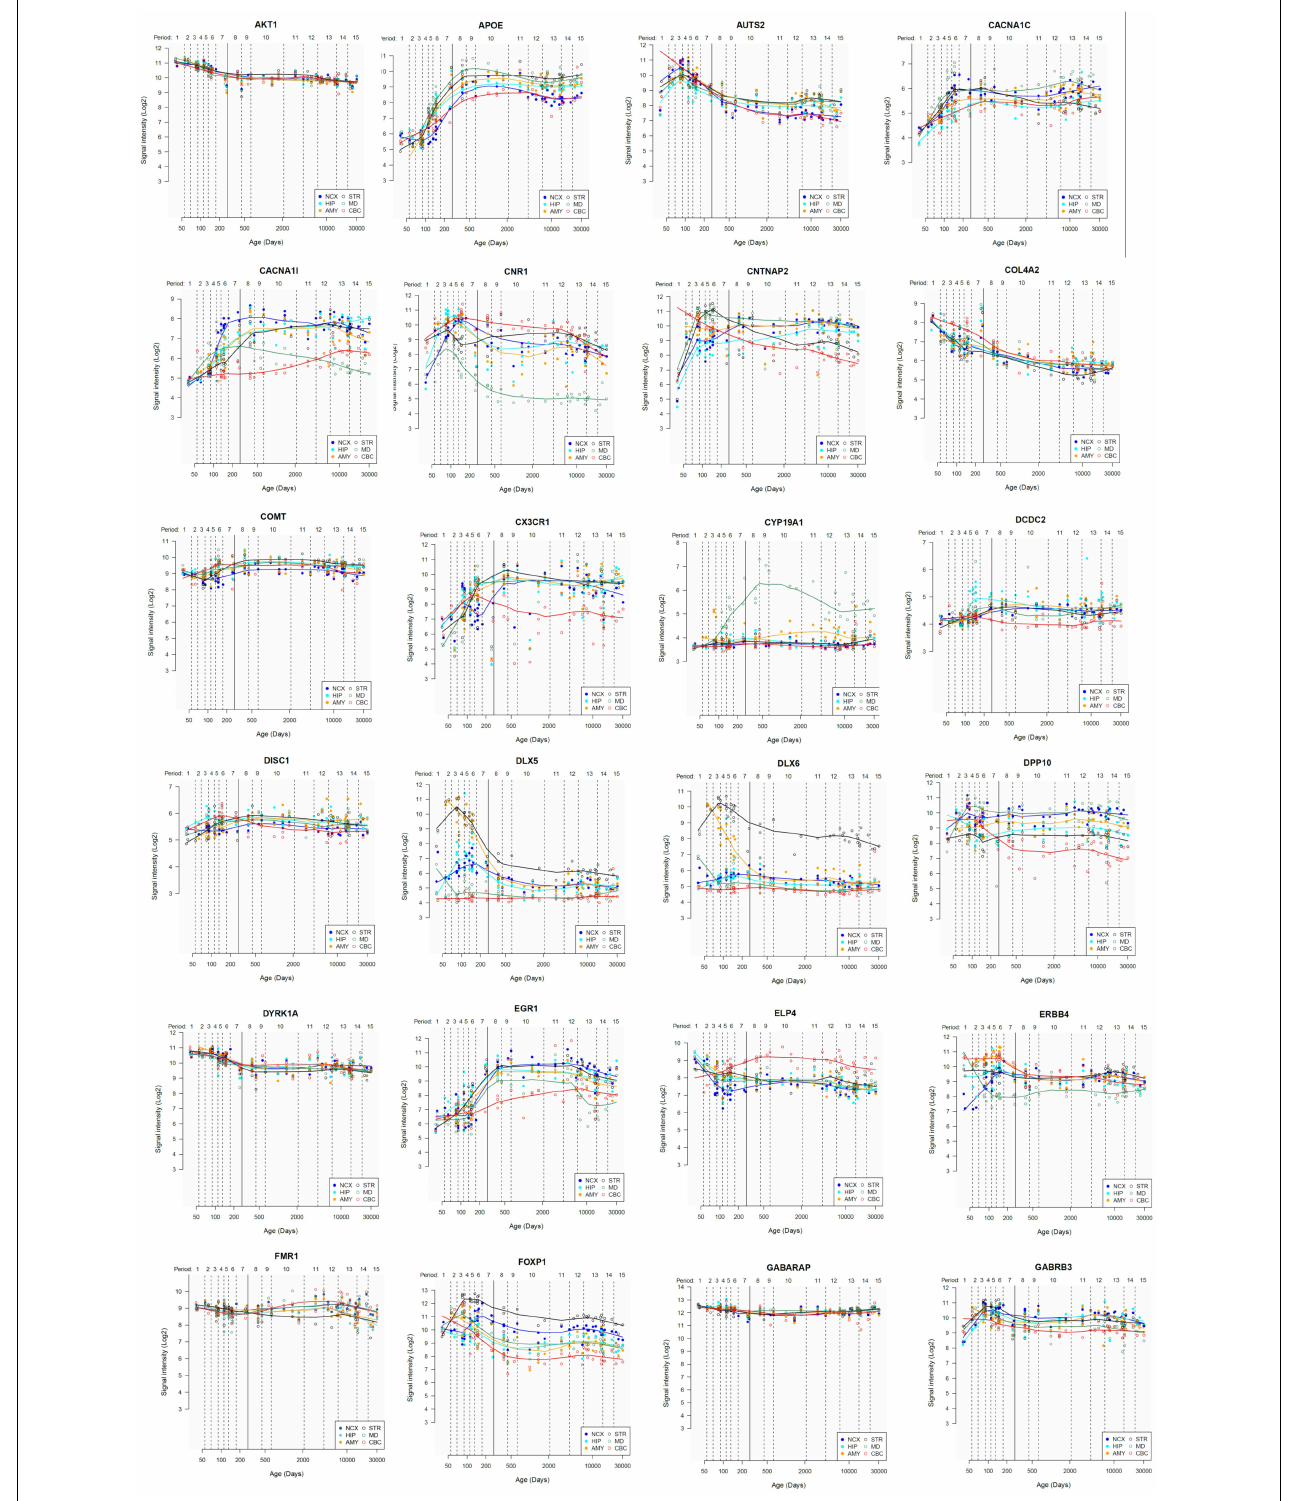
FIGURE 3 | Individual brain expression profiles across development of the set of genes considered in this study (1–24). The expression data are from the Human Brain Transcriptome Database (hbatlas.org/). Six different brain regions are considered: the cerebellar cortex (CBC), the mediodorsal nucleus of the thalamus (MD), the striatum (STR), the amygdala (AMY), the hippocampus (HIP), and 11 areas of neocortex (NCX). Data for SHANK3 were not available.